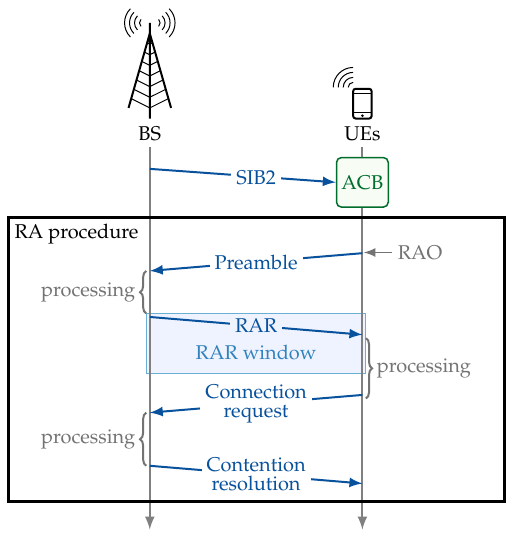
Figure 1. Random access (RA) in LTE-A: ACB scheme and